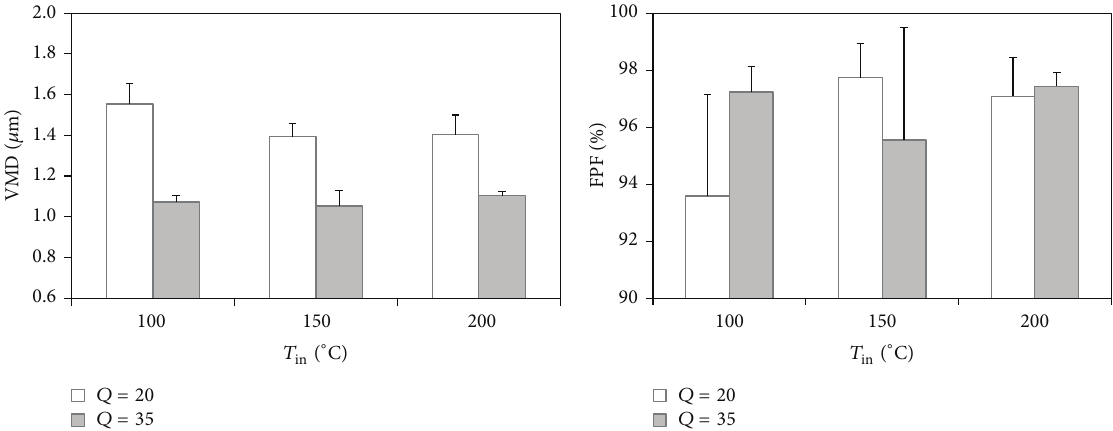
Figure7:Volumetricmediandiameter(VMD)andfractionoffineparticles(FPF)forDACMCmicroparticlesasafunctionofthetemperature and the flow rate of the drying air (m 3 /hr). Error bars denote the standard deviation.